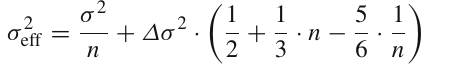
implementation of a DEPFET device capable of RNDR. In